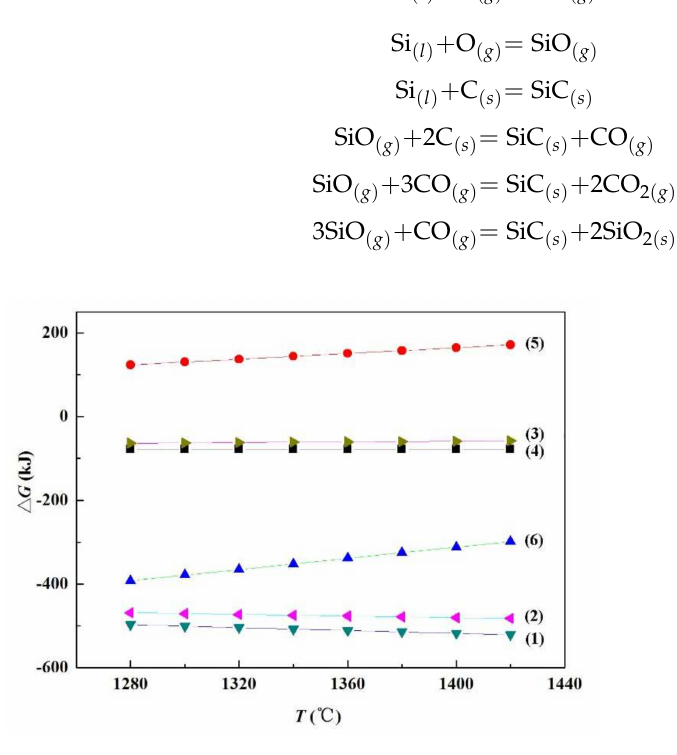
Figure 13. Gibbs free energy for each reaction equation at different